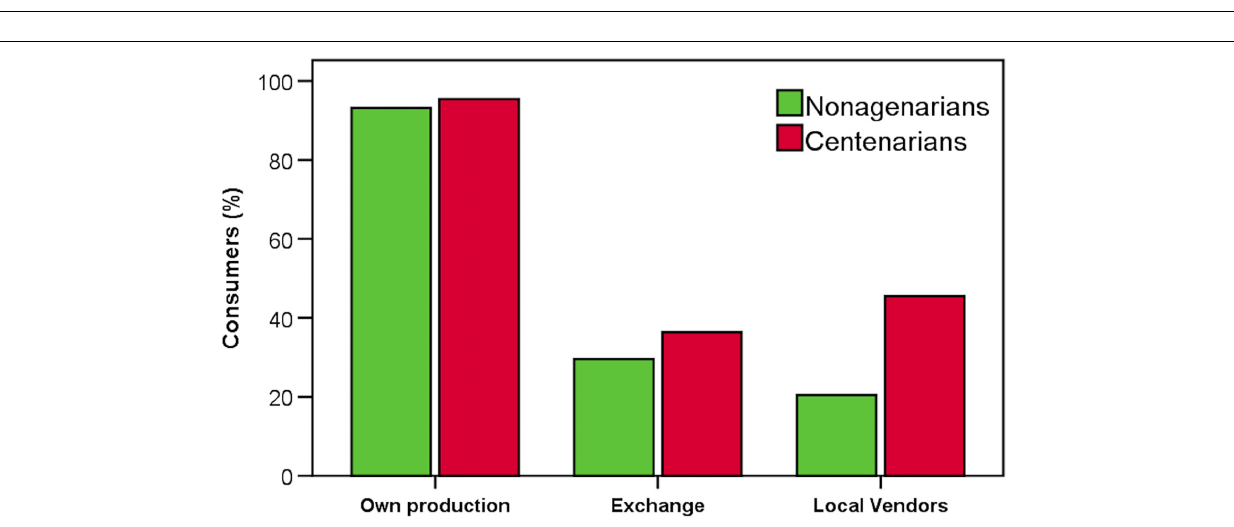
FIGURE 3 | Percentage of consumer use of cooking fat during meal preparation. EVOO, extra-virgin olive oil.